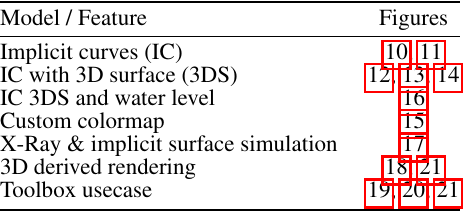
Table 1. List of figures representing each feature and rendering model described in this